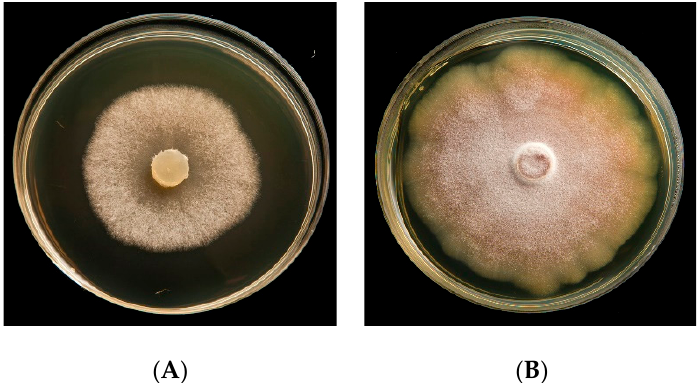
Figure 2. Grow inhibition test ( A ), negative control DMSO ( B ) on Phoma betae. Tables 2 and 3 show the antifungal activity results obtained respectively with bile acids ( 1a,d ) and with secosteroids ( 2a,b , 3c and 4d + 5d ) expressed as growth inhibition percentage related to the negative control. Table 2. Antifungal activity screening obtained with bile acids ( 1a – d ). Strain